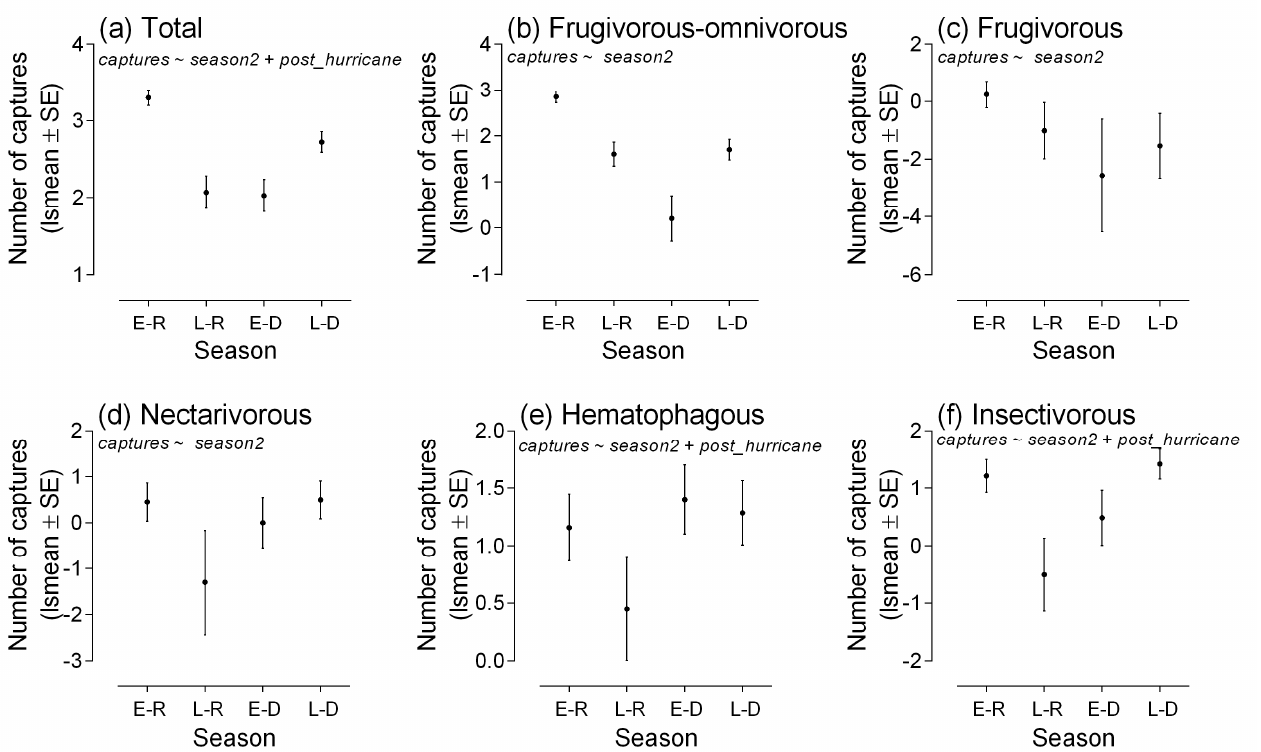
Figure 5. Seasonal variation in abundance of bats (number of captures), total ( a ) and by trophic guilds ( b – f ), in accordance with selected models throughout GLMs. E-R: Early rainy, L-R: Late rainy, E-D: Early dry, L-D: Late dry. Details are shown in Table S1 of Supplementary Materials.